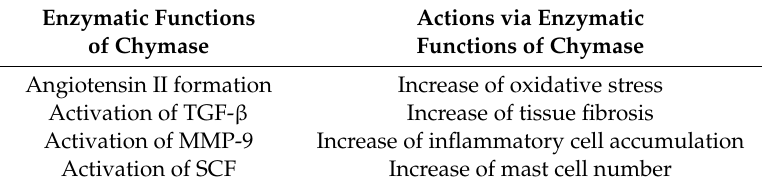
Table 1. Enzymatic function of chymase and their